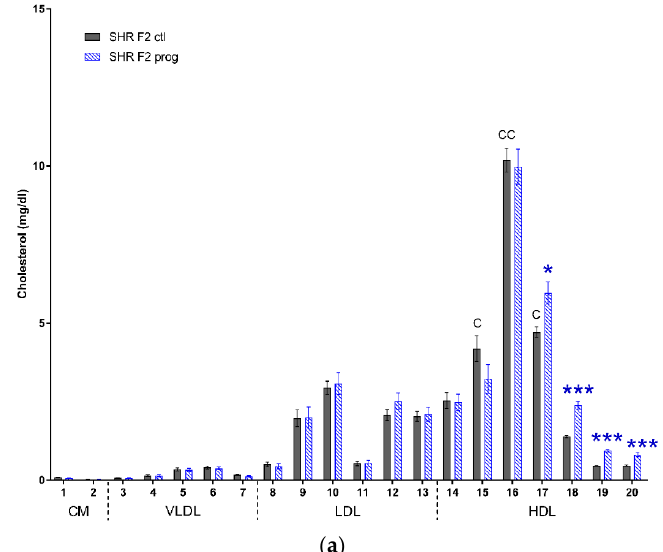
Figure 8. Fasting insulin concentrations in adult SHR F2 control male offspring (dark grey bars), SHR- Zbtb16 F2 control male offspring (light grey bars), F2-programmed SHR male offspring (blue patterned bars), F2-programmed SHR-Zbtb16 male offspring (green patterned bars) in 6 months of age. The strain comparison using the post-hoc Fisher’s least significant difference test of the two-way ANOVA for STRAIN and PROGRAM as major factors are indicated as follows: * p < 0.05. Effect of programming in SHR-Zbtb16 strain is represented by green asterisks